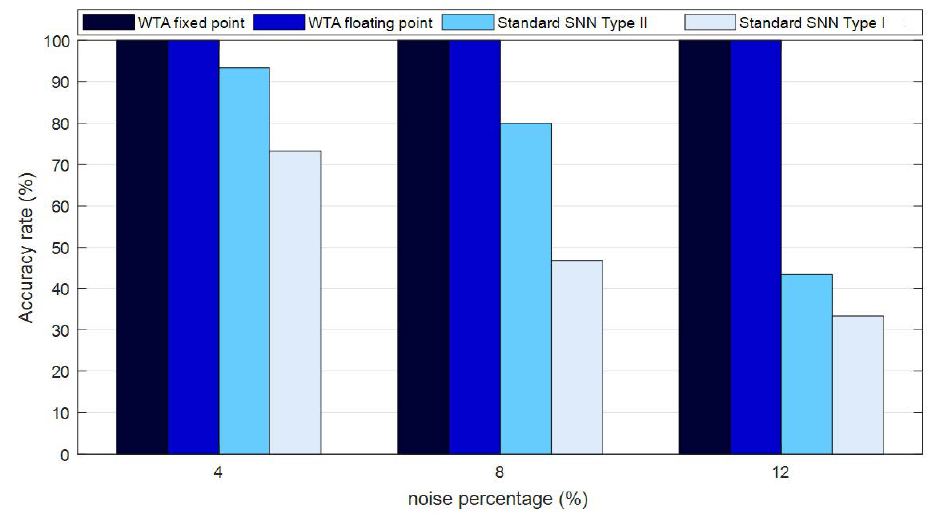
Figure 13. Comparison of the obtained recognition accuracy of the standard SNN in [16] and our spiking WTA .